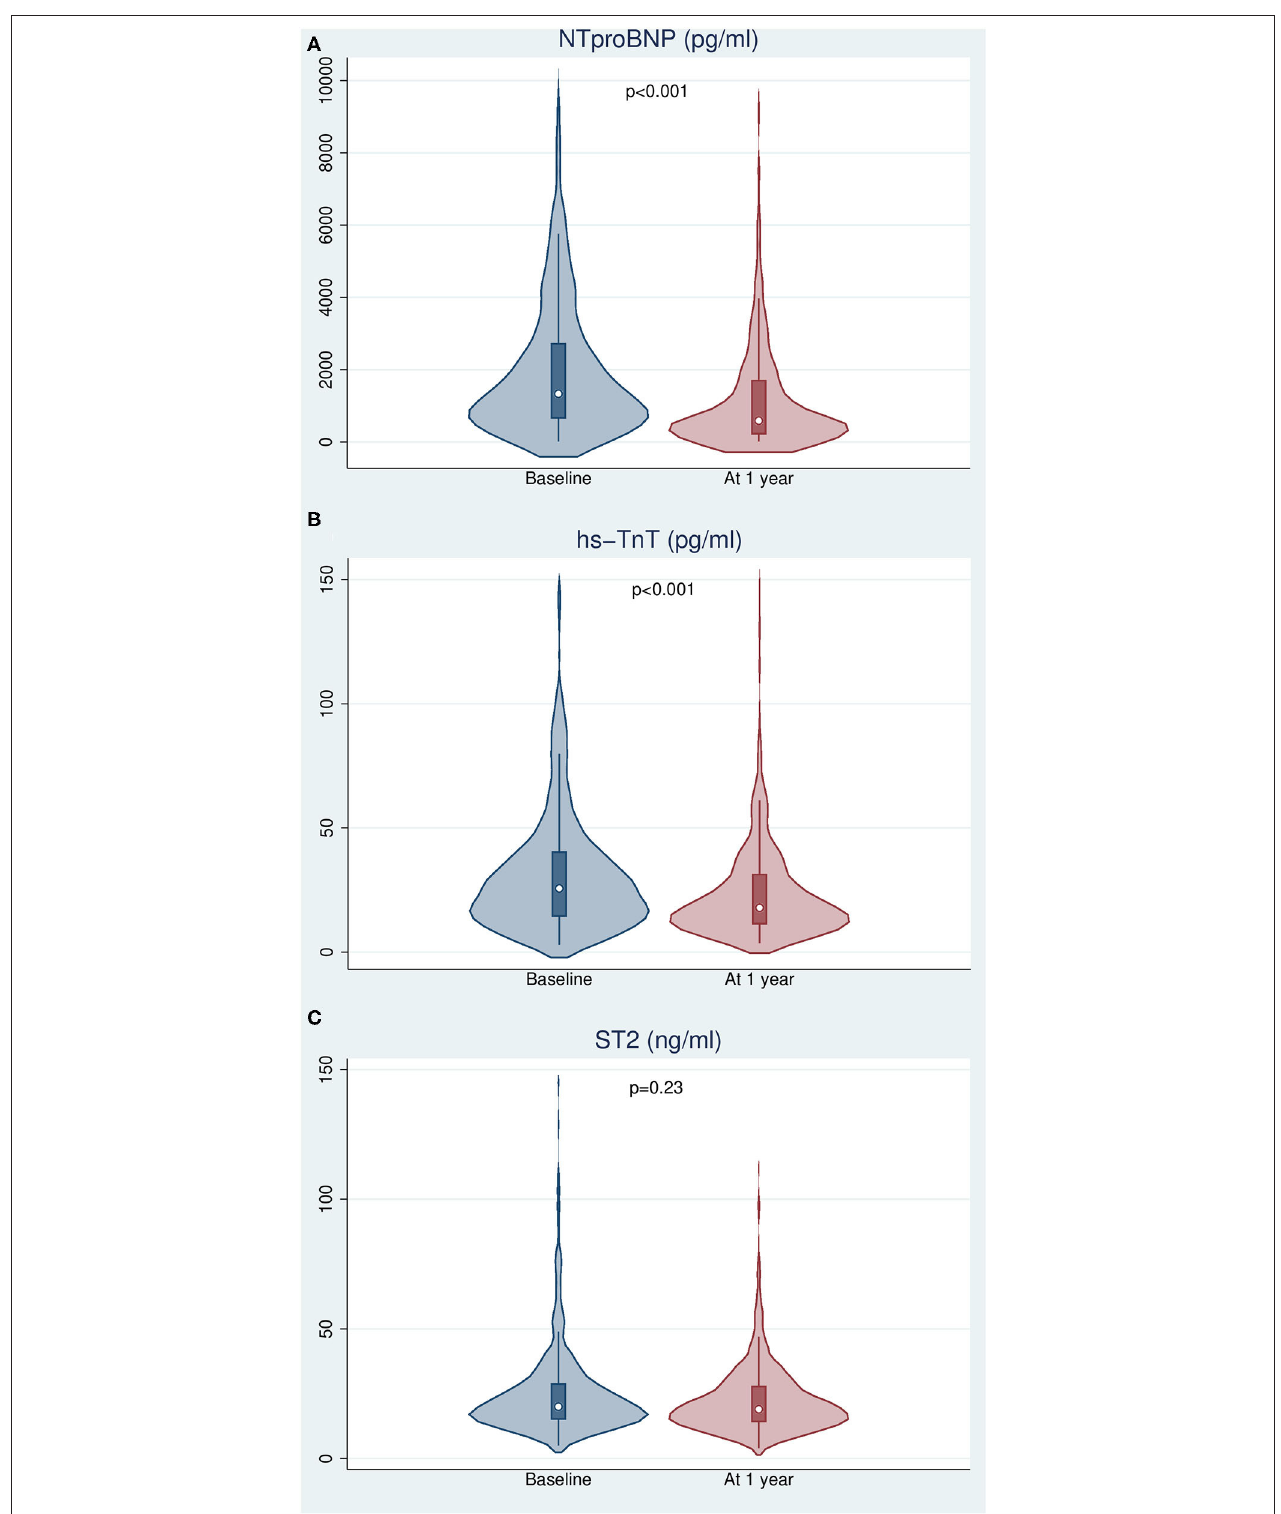
FIGURE 2 | Changes in biomarker levels after 12 months of follow-up. (A) N-terminal pro-brain natriuretic peptide. (B) High sensitivity troponin T. (C) Interleukin 1 receptor-like 1 (ST2).